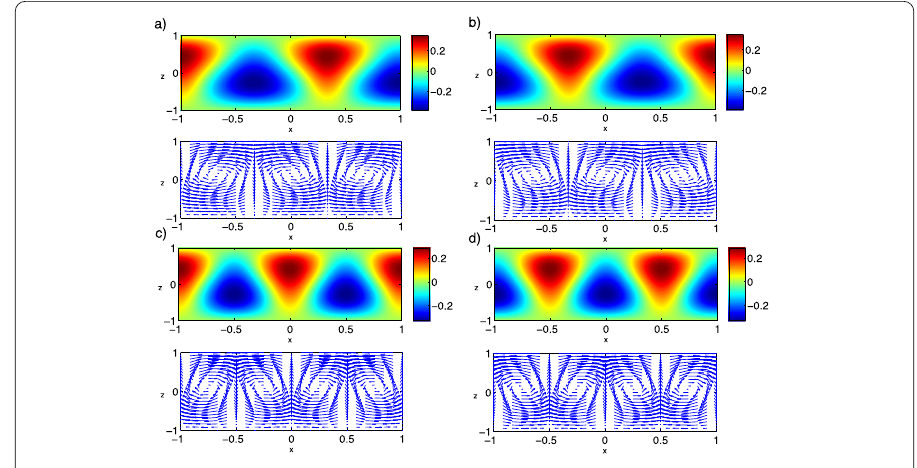
Figure 1 ( a ) Isotherms and velocity field for R = 1900 for solution S 1 and ( b ) S 2 ; ( c ) isotherms and velocity field for R = 1900 for solution S 3 and ( d ) S 4